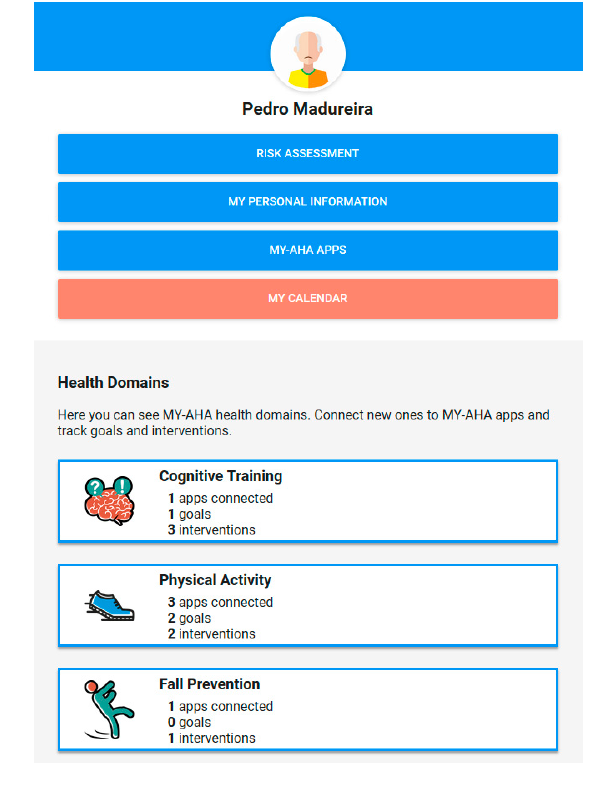
Figure 4. Dashboard home screen.